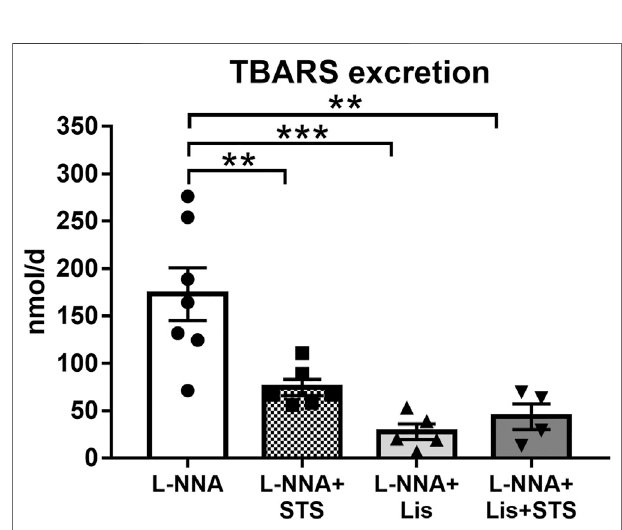
FIGURE 6 | Oral treatment with STS reduces oxidative stress. The excretion of thiobarbituric acid reactive substances (TBARS) in urine was measured as a marker for systemic oxidative stress. N (cid:2) 4 – 7. ** p < 0.01, *** p <